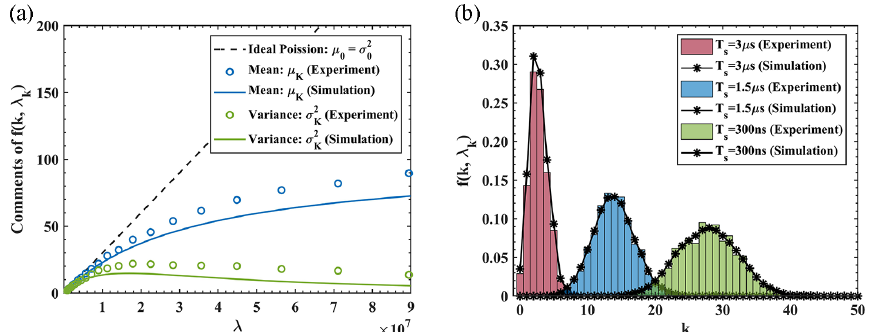
Figure 11. PCM photocounts characteristics: ( a ) Mean and variance of photocounts with t = 3 µs, ( b ) probability density distribution of PCM photocounts for T s = 3 µs,1.5 µs, 0.3 µs, λ s = 2 × 10 7 photo-